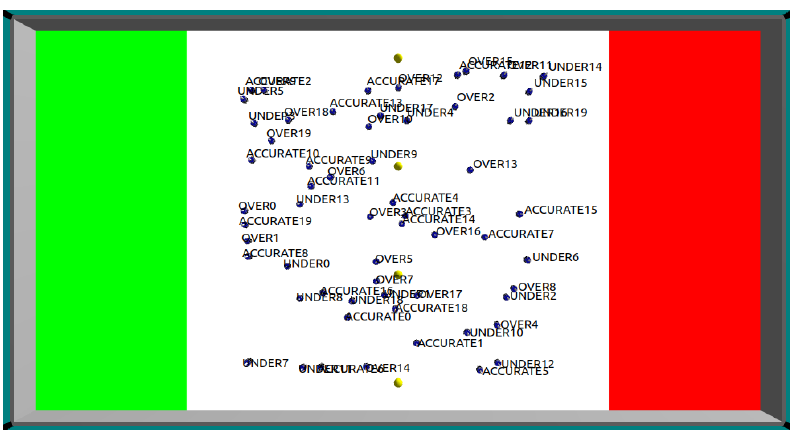
Figure 3. Snapshot of the site selection arena in ARGoS